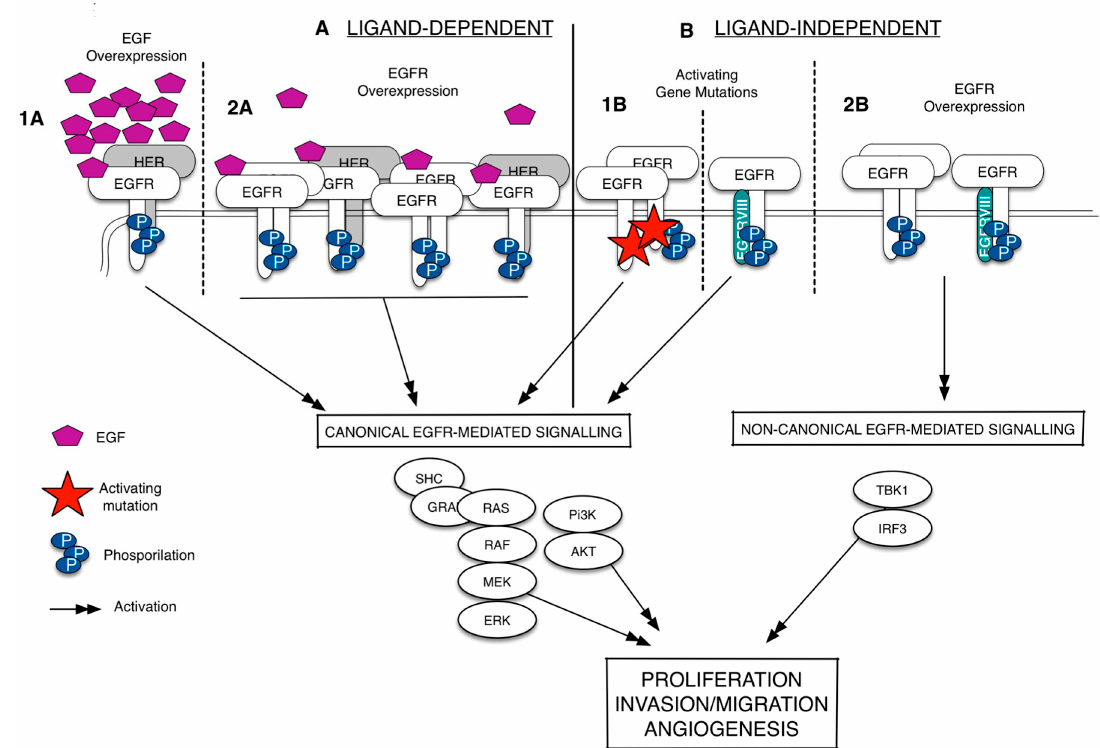
Figure 1. Epidermal growth factor receptor (EGFR) signaling deregulation in cancer. The EGFR signaling can be deregulated in a ligand-dependent ( A ) or ligand-independent manner ( B ). The ligand-specific activation of the wild-type epidermal growth factor receptor (EGFRwt), which occurs via EGF overexpression ( 1A ) or EGFR overexpression ( 1B ), leads to the EGFR homodimerization/heterodimerization, phosphorylation of specific tyrosine residues and recruitment of several proteins at the intracellular portion of the receptors. It activates a series of signal transduction pathways (black arrows), including the canonical signals as such as ERK and Akt. The ligand-independent activation happens when the EGFR shows activating gene mutations. These mutations can occur in the EGFR intracellular domain or in the EGFR extracellular domain to form a constitutively active protein (EGFRvIII) ( 1B ). Without ligand, the EGFRwt overexpression can also lead to the EGFR phosphorylation and the activation of a non-canonical form of signaling that results in the activation of the transcription factor IRF3 ( 2B ). Dash lines separates the different mechanisms of EGFR activation.